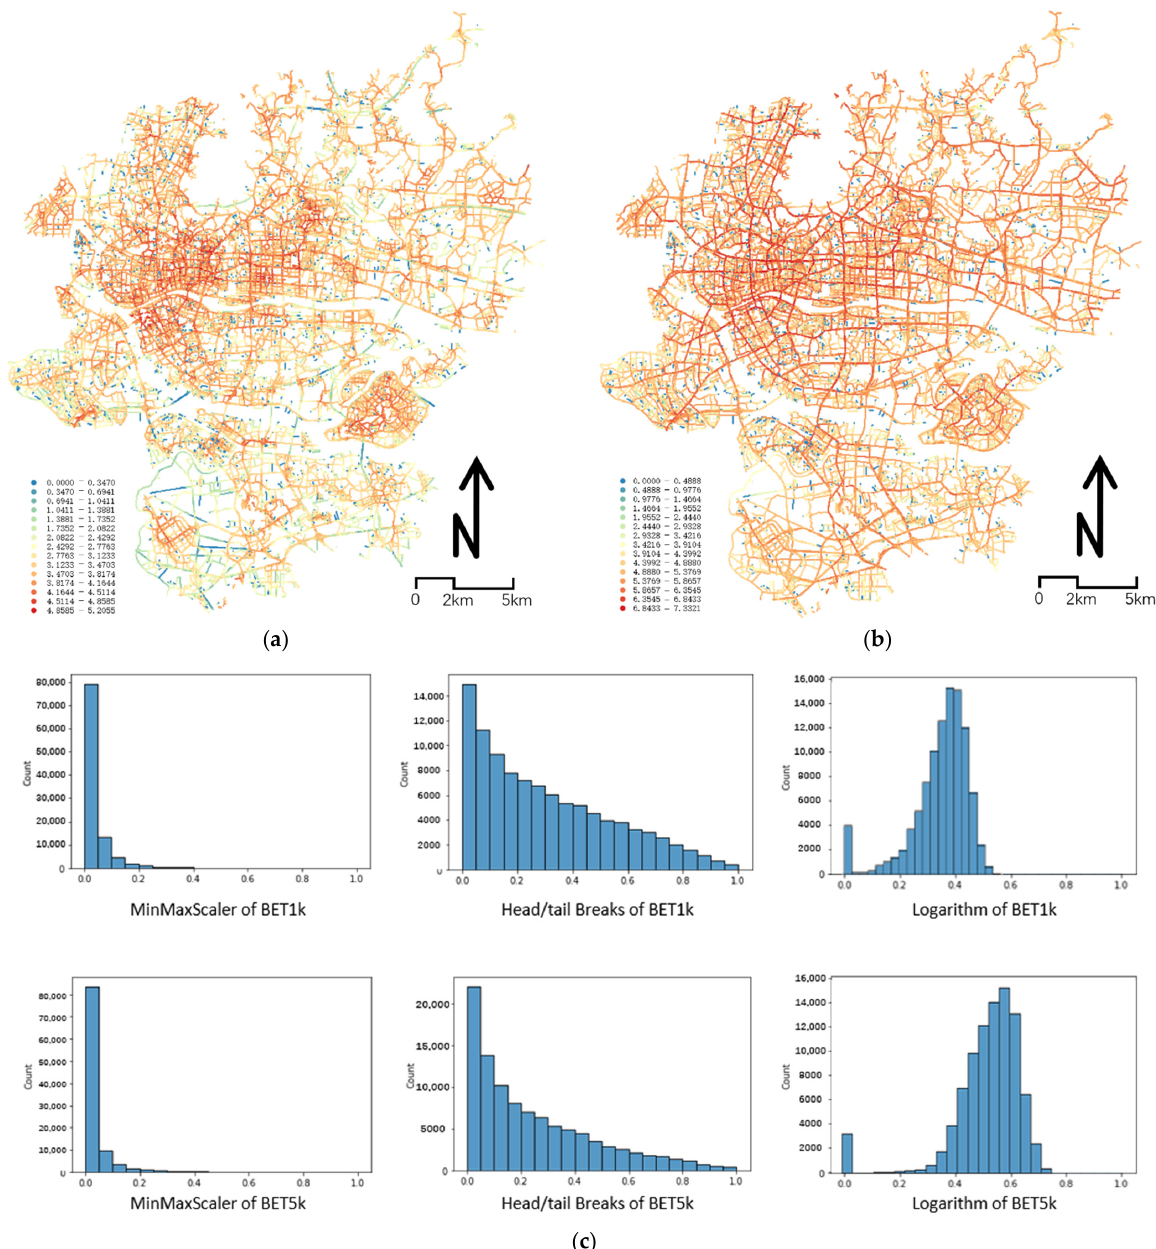
Figure 8. Spatial distribution of betweenness (movement potentials) at radii ( a ) Logarithm of Be- tweenness/Choice 1 km and ( b ) Logarithm of Betweenness/Choice 5 km and ( c ). Histogram of Betweenness/Choice at 1 km and 5 km in Central Guangzhou (N = 101,035). Normalized by MinMaxScaler, Head/tail Breaks and logarithm.